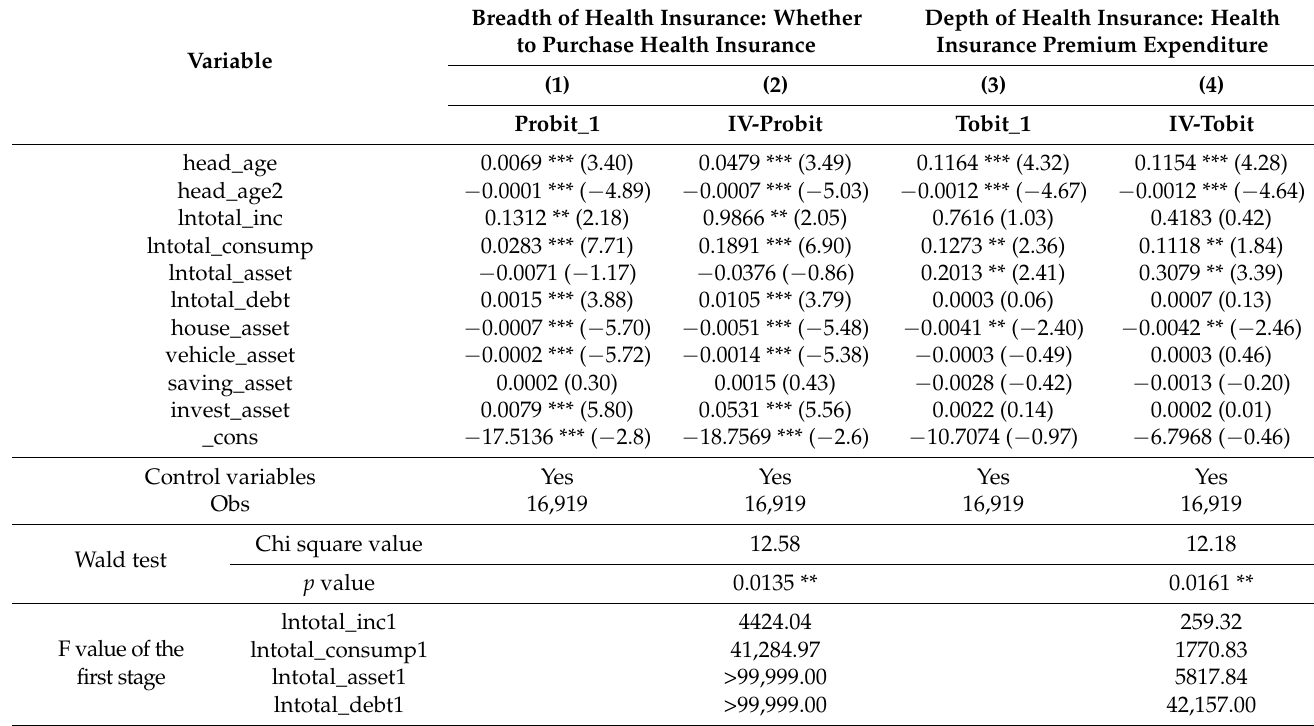
Table 8. Endogeneity test of the